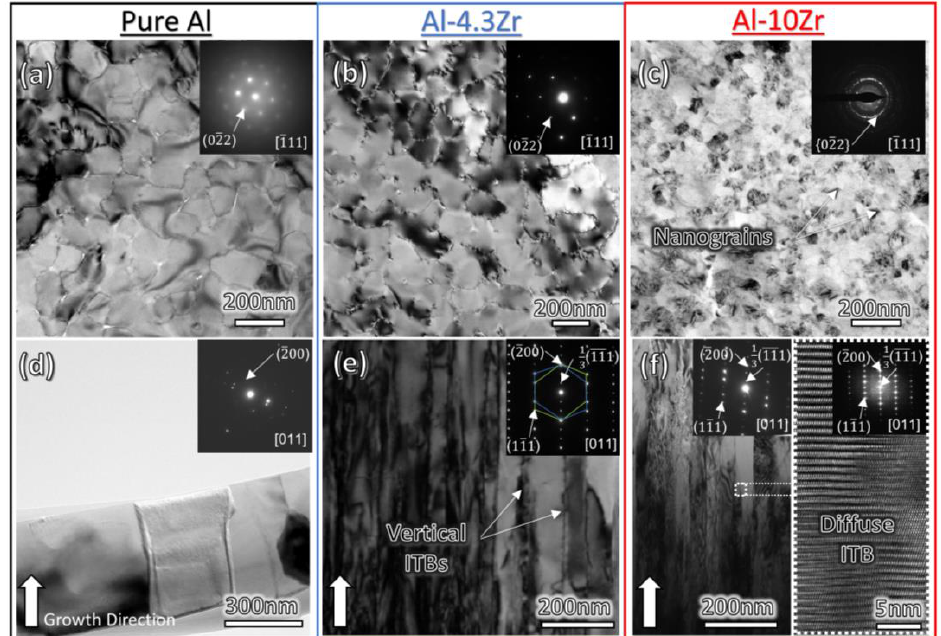
Figure 2. ( a ) Plan-view (PV) transmission electron microscopy (TEM) micrograph of the ultra-fine-grained pure Al film with the corresponding inserted selected area diffraction (SAD) pattern revealing the single-crystal-like (111) out-of-plane texture. ( b ) PV-TEM micrograph of the NT Al – 4.3Zr alloy film revealing fine grains and the corresponding SAD pattern identifying the single-crystal-like (111) texture. ( c ) PV-TEM micrograph of the NT Al – 10Zr alloy film revealing fine grains and the corresponding SAD pattern showing a strong (111) out-of-plane texture. ( d ) Cross-section TEM (XTEM) micrograph of pure Al with the corresponding SAD pattern. ( e ) XTEM micrograph of the NT Al – 4.3Zr alloy with the corresponding SAD pattern revealing columnar nanotwin boundaries. ( f ) XTEM micrograph of the NT Al – 10Zr alloy with the corresponding SAD pattern revealing columnar nanotwin boundaries and a high-resolution TEM (HRTEM) inset highlighting the periodic stacking fault array in diffuse ITBs or the 9R phase.